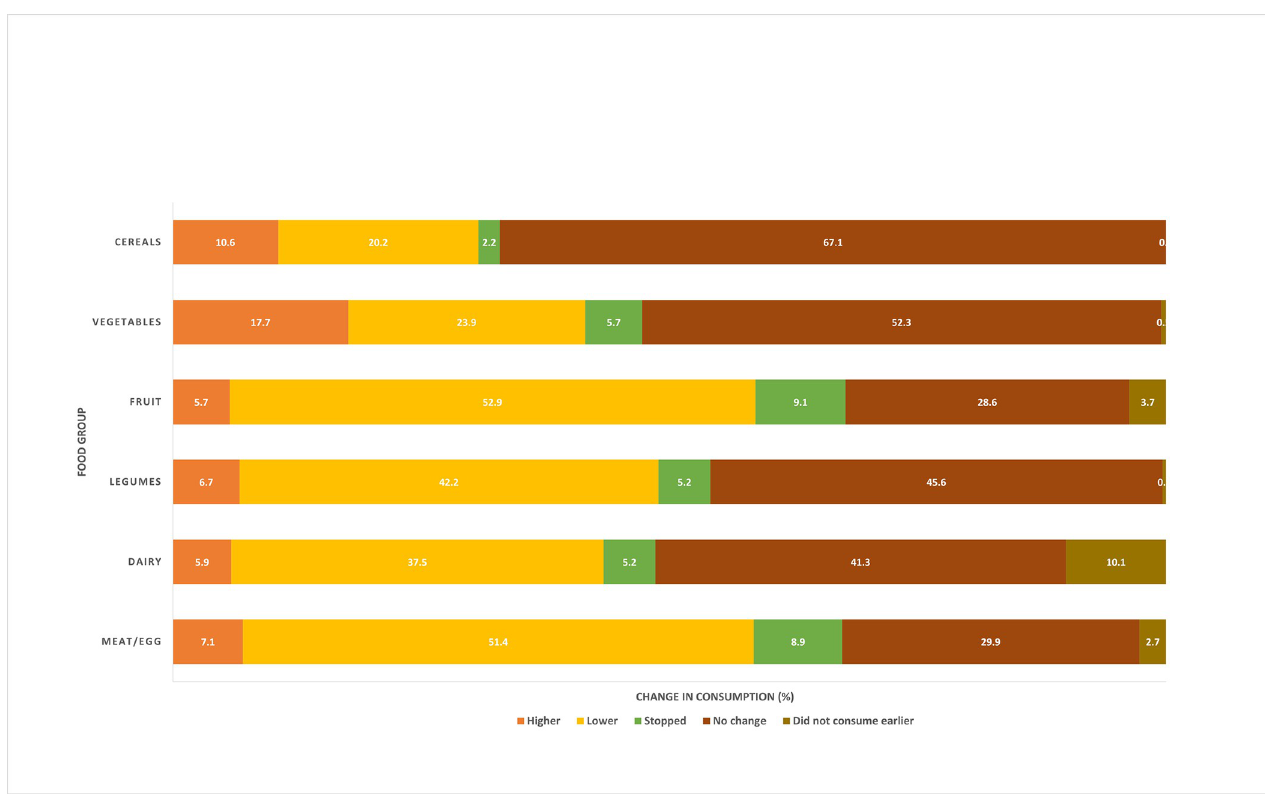
Fig 2. Self-reported changes in household diets since